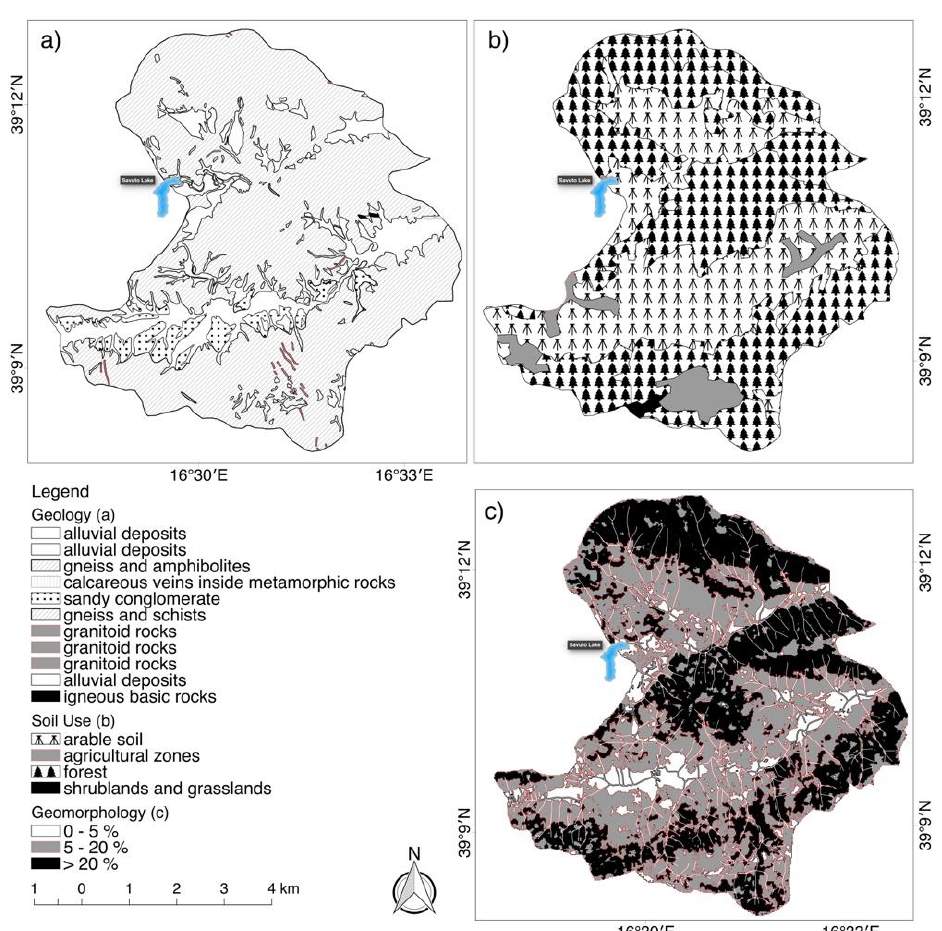
Figure 7. ( a ) Simplified geological map (modified from [41]). ( b ) Soil use map form Corine Land Cover [42]. ( c ) Slope map obtained starting from 20 × 20m DEM.